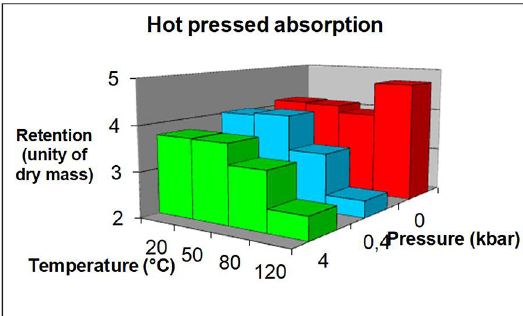
Figure 4. Retention of hot pressed membranes (normalized to the mass of the dry sample).